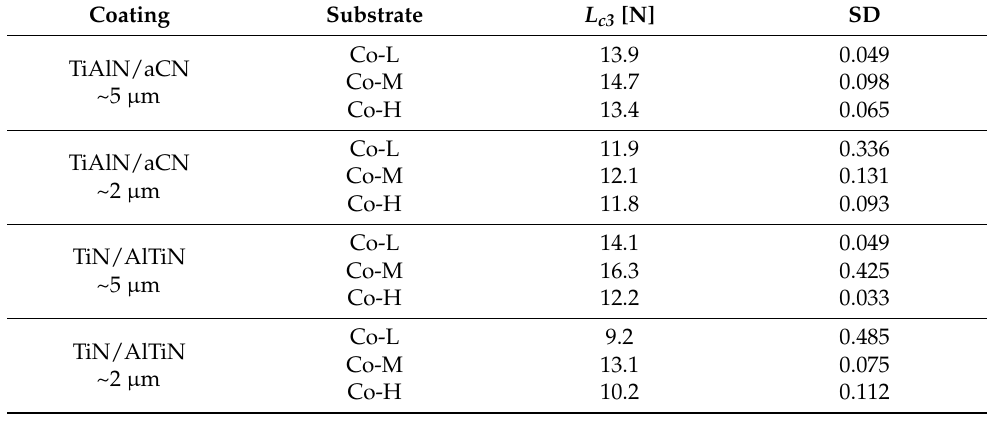
Table 5. Critical load L C3 of the nanolayer TiN/AlTiN and TiAlN/a-C:N double layer coatings deposited on Co-L, Co-M and Co-H substrates.